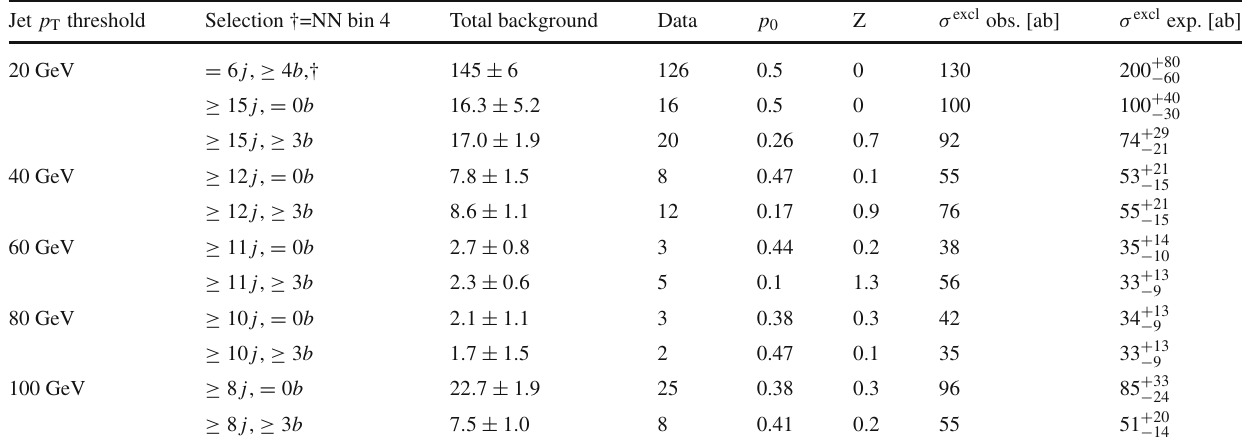
and efficiency (in ab) are also shown ( σ excl ). In SRs with a deficit of data compared to the background prediction the p 0 -value is capped at 0.5. The parameters of the background model are determined in a fit to a reduced set of bins, corresponding to the model-independent fit discussed in the text